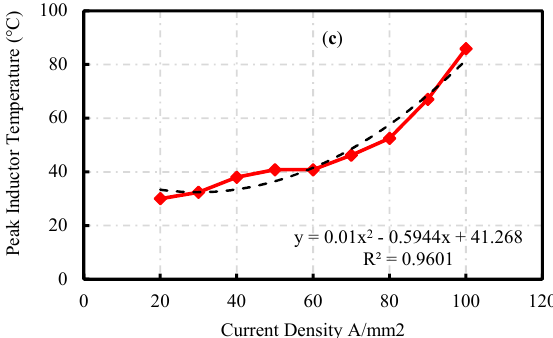
Figure 20. Integrated Inductor ( a ) on Power Module Substrate [39] ( b ) on Double side power module substrate [42] ( c ) Temperature vs. Current Results [42].